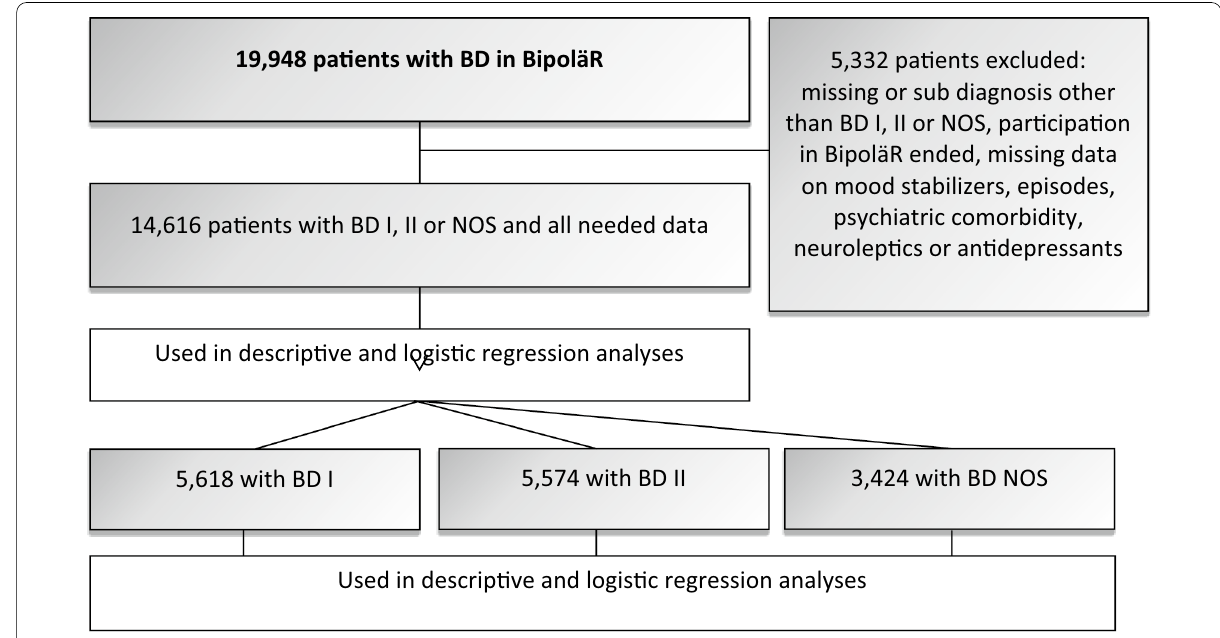
Fig. 1 Flowchart of inclusion and exclusion of study